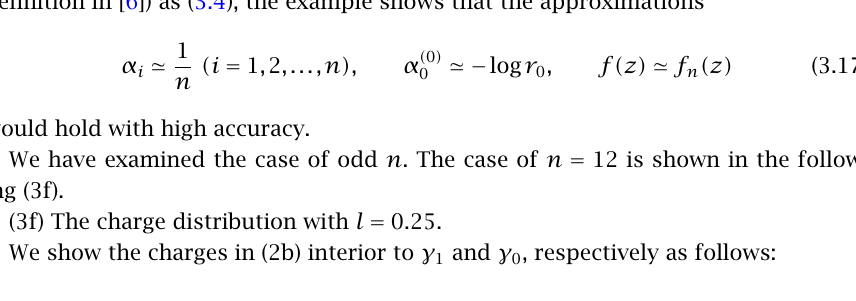
Table 3.13 . The charge distribution with n = 12 , l = 0 . 25 on γ 1 .